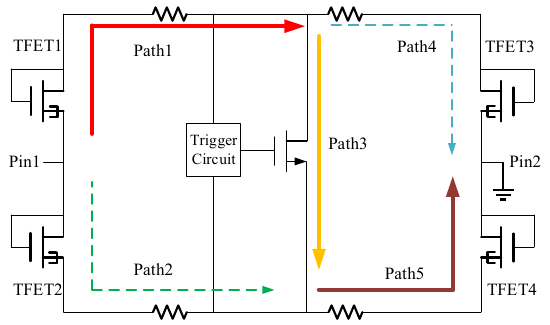
Figure 7. Whole-chip electrostatic discharge (ESD) protection network.